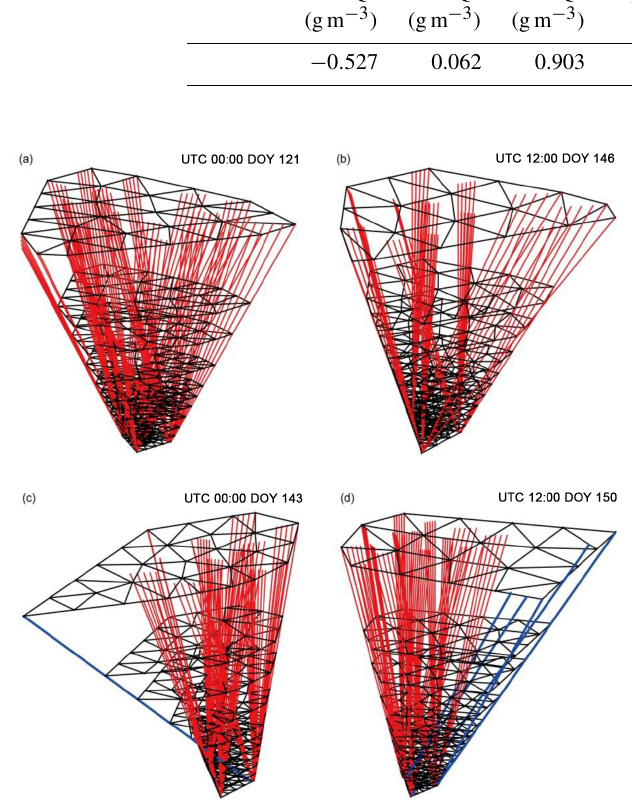
Figure 9. Tomographic field and signal distribution at tomographic epoch 00:00UTC on DOY 121 (a) , 12:00 UTCon DOY 146 (b) , 00:00UTC on DOY 143 (c) , and 12:00UTC on DOY 150 (d)